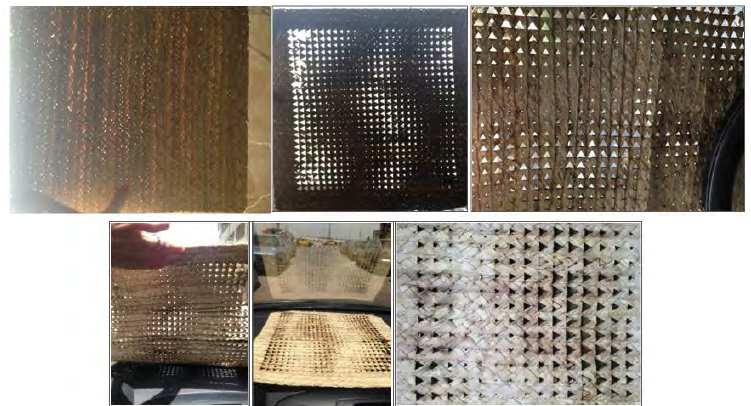
Figure 16. Palm leaves mat before and after laser cut and how it helped to change the users perception to the material.